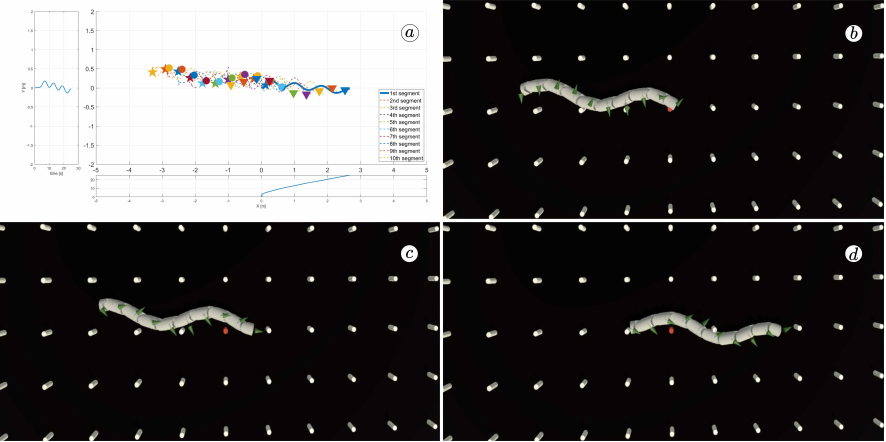
Figure 30. Trajectories of robot segments for φ i ,ref = 50 ◦ sin ( 60 ◦ t + ( i − 1 ) 60 ◦ ) ( a ) and robot configu- rations for t = 5 ( s ) ( b ), t = 10 ( s ) ( c ), and t = 24 ( s ) ( d